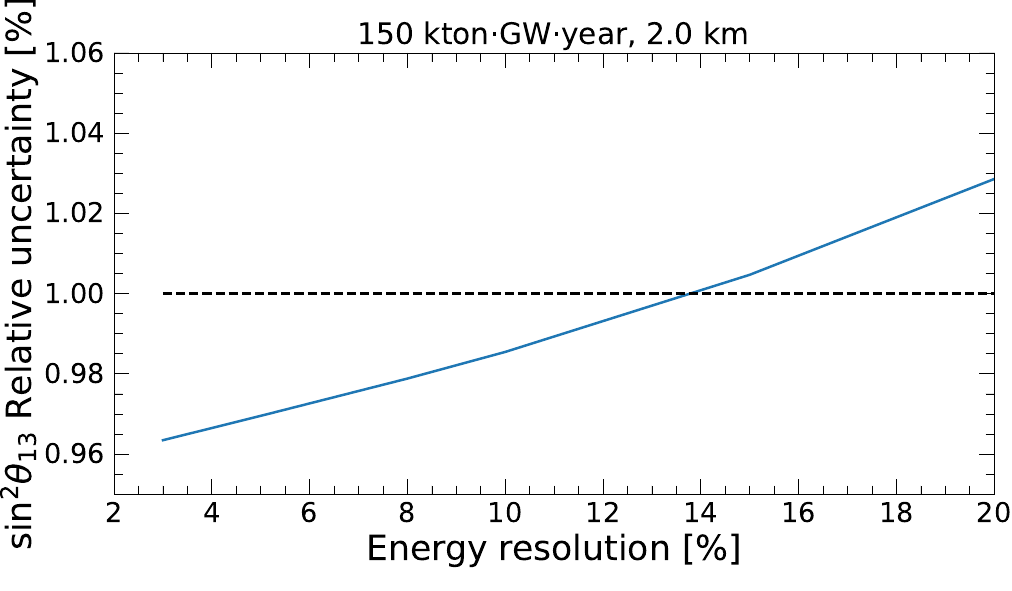
Figure 7 . The sin 2 θ 13 1 σ precision sensitivity for the experiment with different prompt energy resolutions. The sin 2 θ 13 precision sensitivity’s relative variation would be within 5% for the energy p p resolution from 3% / E (MeV) to 15% / E (MeV)